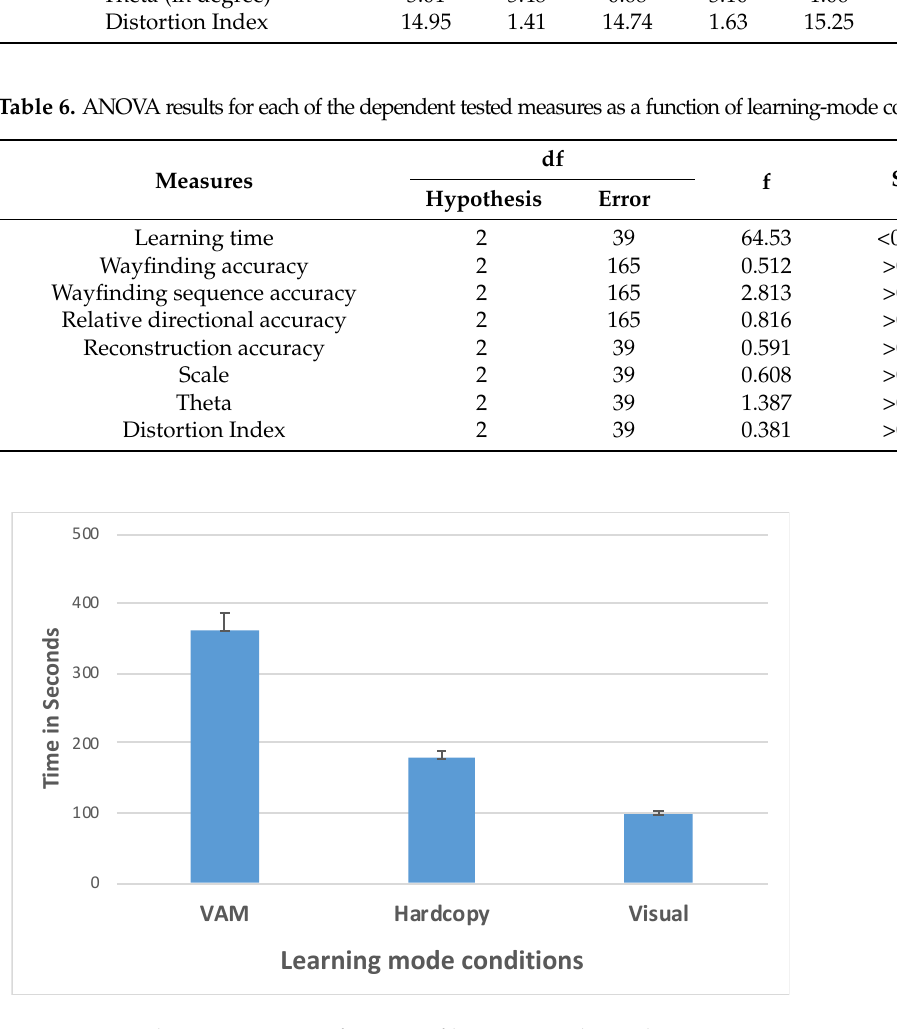
Figure 7. Mean learning time as a function of learning-mode conditions. Table 6. ANOVA results for each of the dependent tested measures as a function of learning-mode